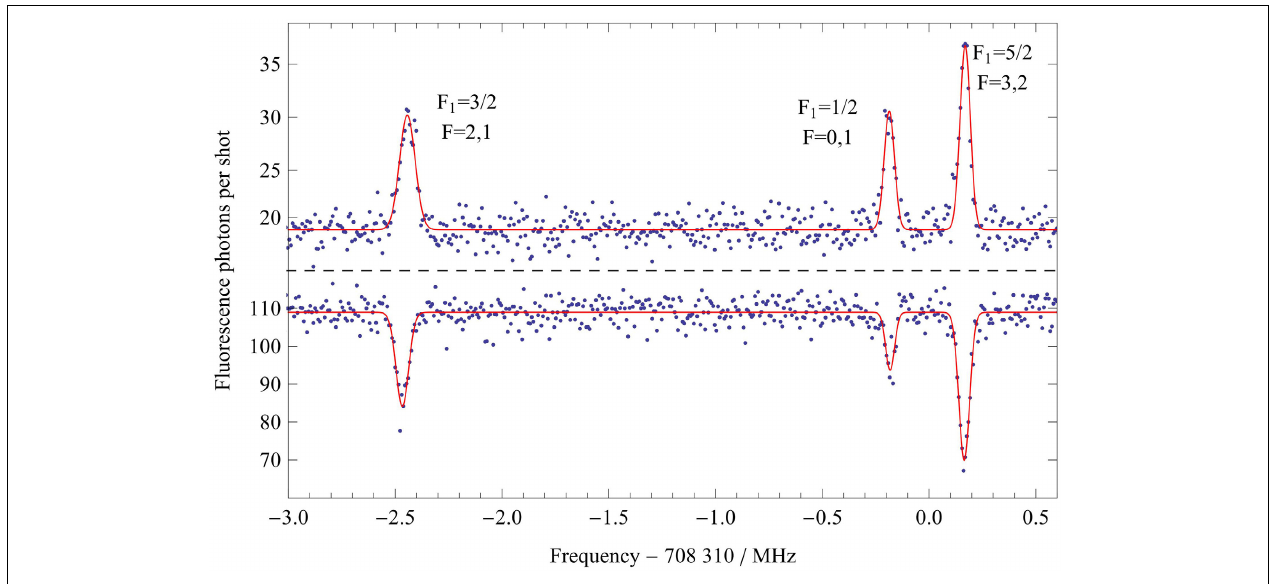
FIGURE 5 | Millimeter-wave spectra of the lowest rotational transition of X, showing the main hyperfine structure in the J = 1 state. In the lower trace the population is measured in J = 0 as the